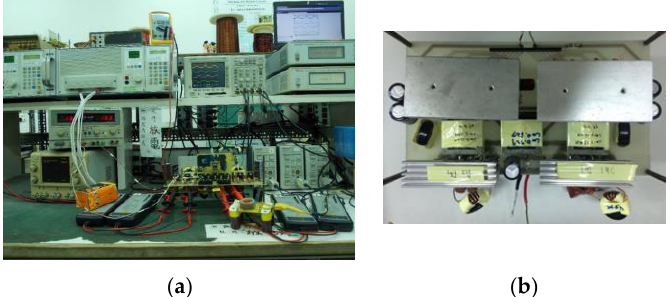
Figure 5. Pictures of the presented circuit in the laboratory: ( a ) experimental setup and ( b ) prototype circuit.